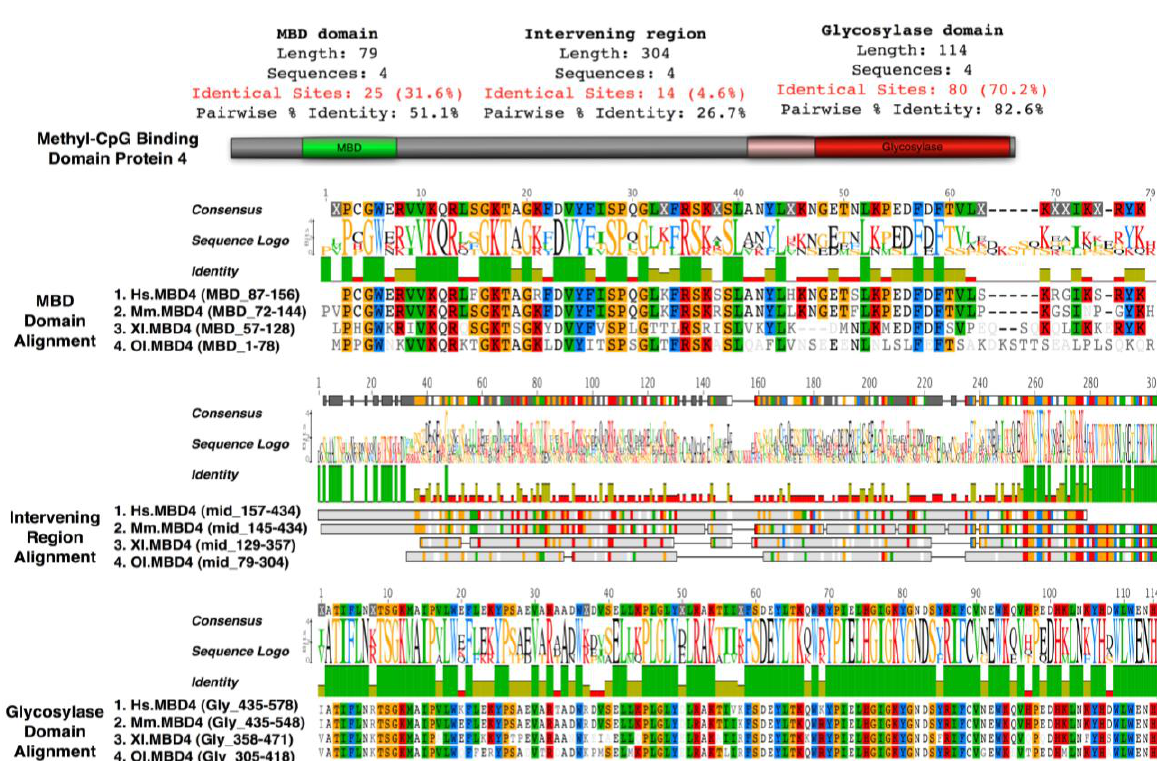
Figure 2. Functional domains of Methyl-CpG binding domain protein 4 (MBD4).